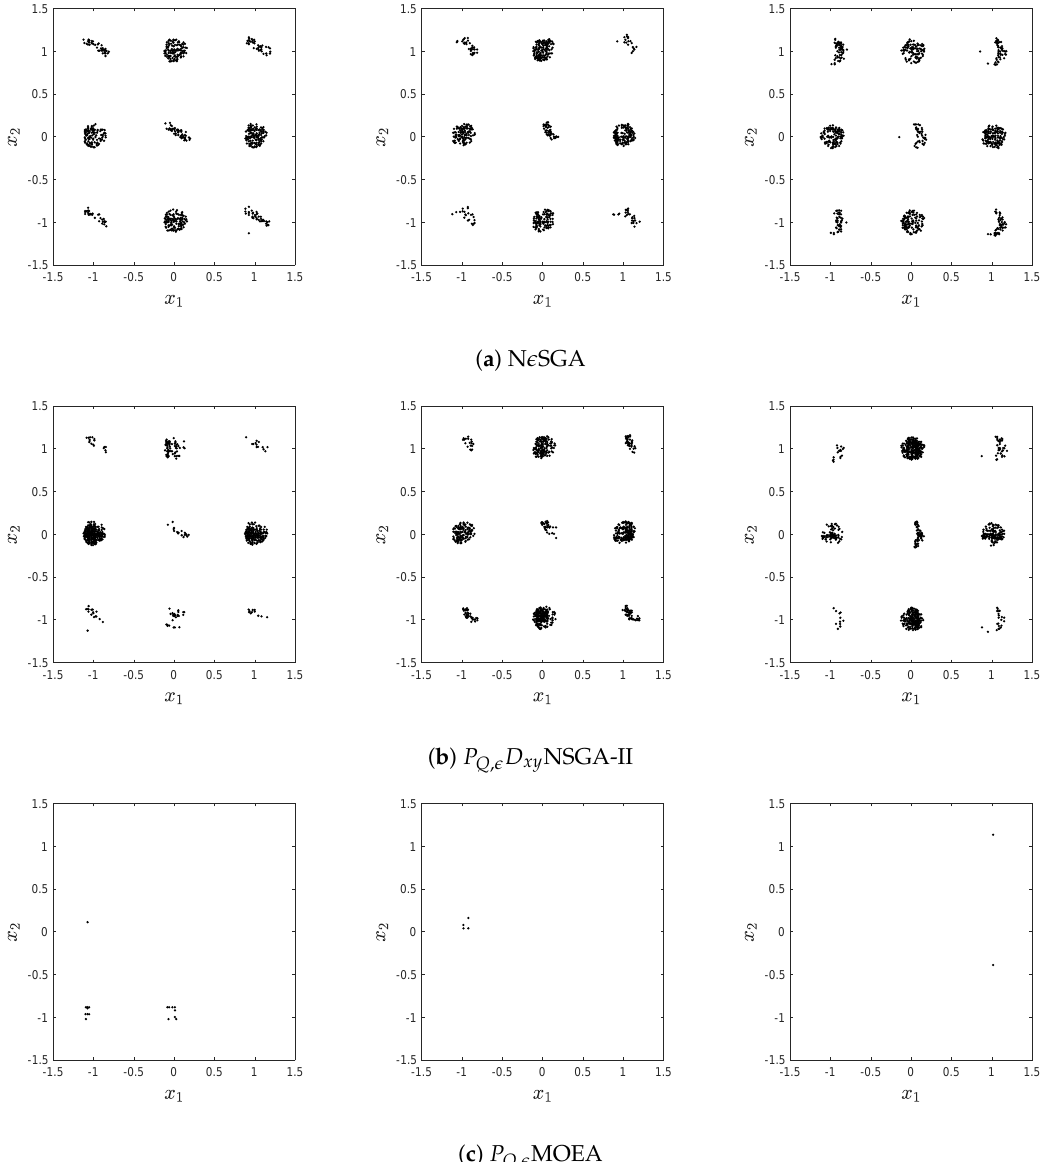
Figure 7. Numerical results on DBMOPPs for the comparison of N e SGA2 and the state-of-the-art algorithms.